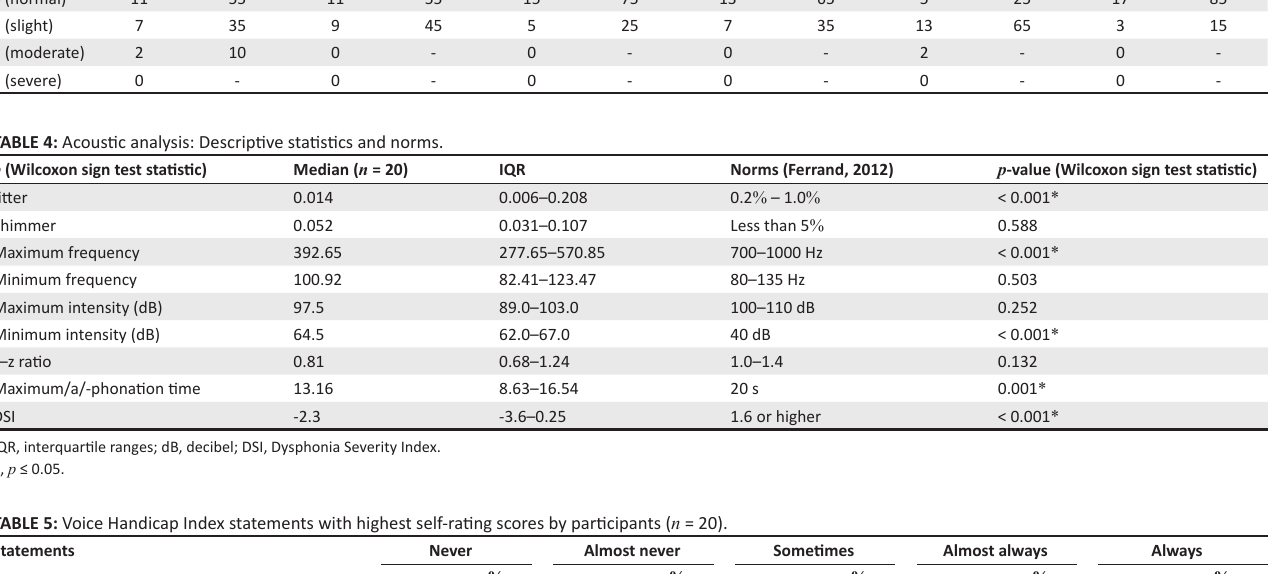
TABLE 3: Consensus scores of participants ( n = 20) across grade of hoarseness, roughness, breathiness, asthenia, strain and instability scale. Consensus score